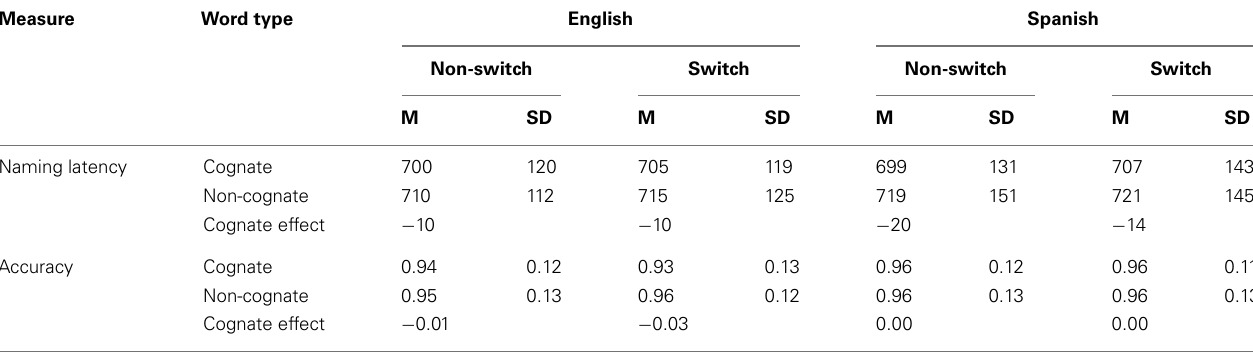
Table 2 | Mixed-language results.